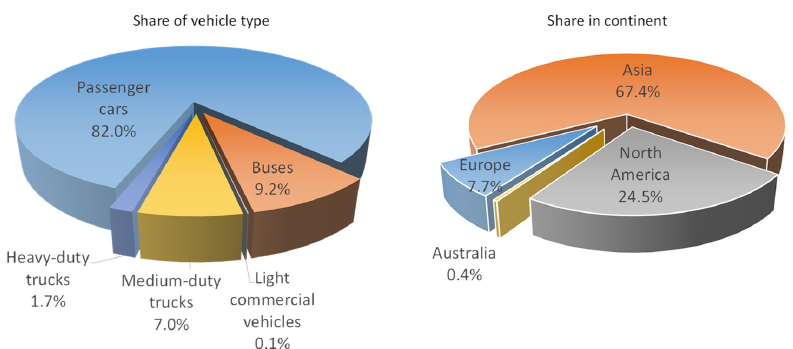
Figure 2. Shares of various vehicle classes according to Table 1 ( left ) and of FCVs on different continents ( right ).